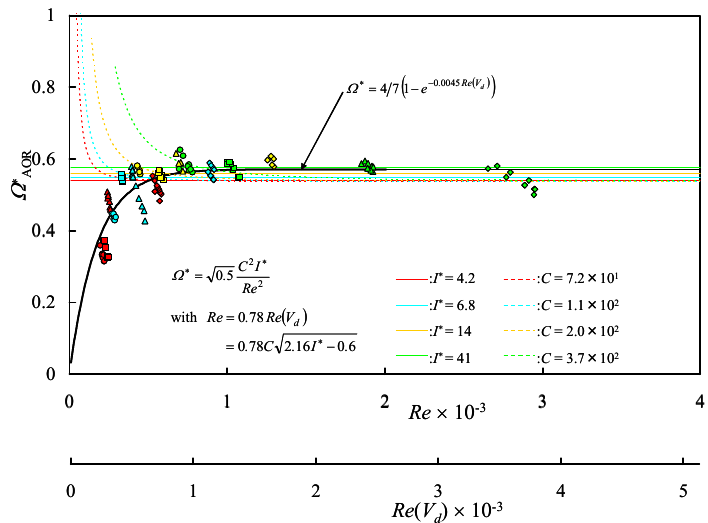
Fig. 15 Reduced rotating rate Ω * AOR averaged over one rotation versus Reynolds number Re , for λ = 0.3, AR = 10, C = 7.2 × 10 1 − 3.7 × 10 2 and I * = 4.2 −